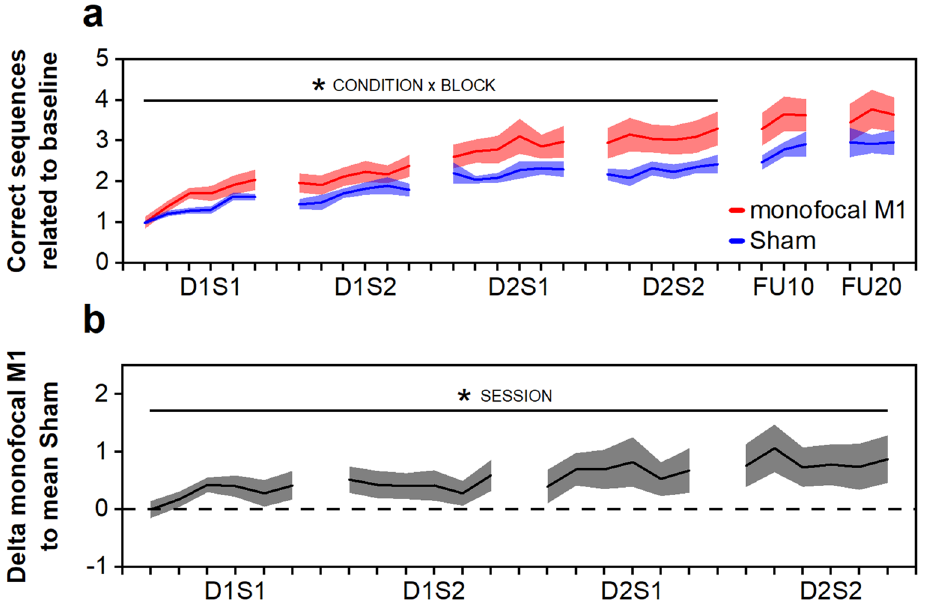
Figure 1. Multisession monofocal M1 stimulation. D1S1, day 1 session 1; D1S2, day 1 session 2; D2S1, day 2 session 1; D2S2, day 2 session 2; FU10, circa. 10 day follow-up; FU20, circa. 20 day follow-up. Margins of error correspond to standard error of the mean. ( a ) Learning curves of the monofocal M1 (red) and the sham group (blue). ( b ) Analysis of additive effects. Depicted is the mean of the individual learning trajectories of the monofocal M1 group related to the mean sham trajectory during the training phase. * depicts p < 0.05 for ( a ) interaction effect CONDITION × BLOCK, ( b ) main effect